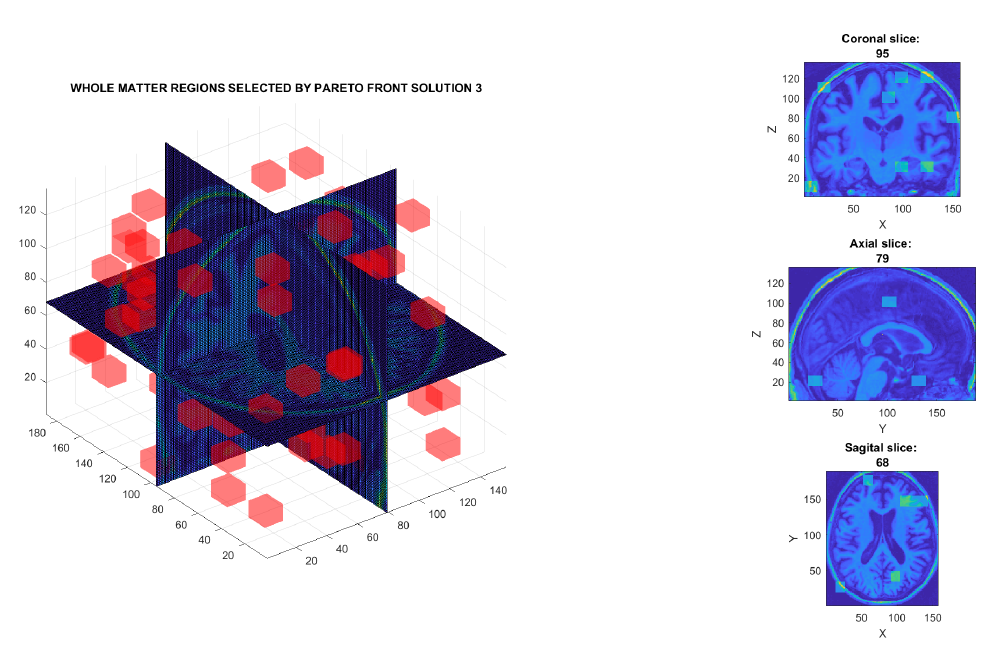
Figure 15. Selected brain regions from the third Pareto solution (gray matter source,